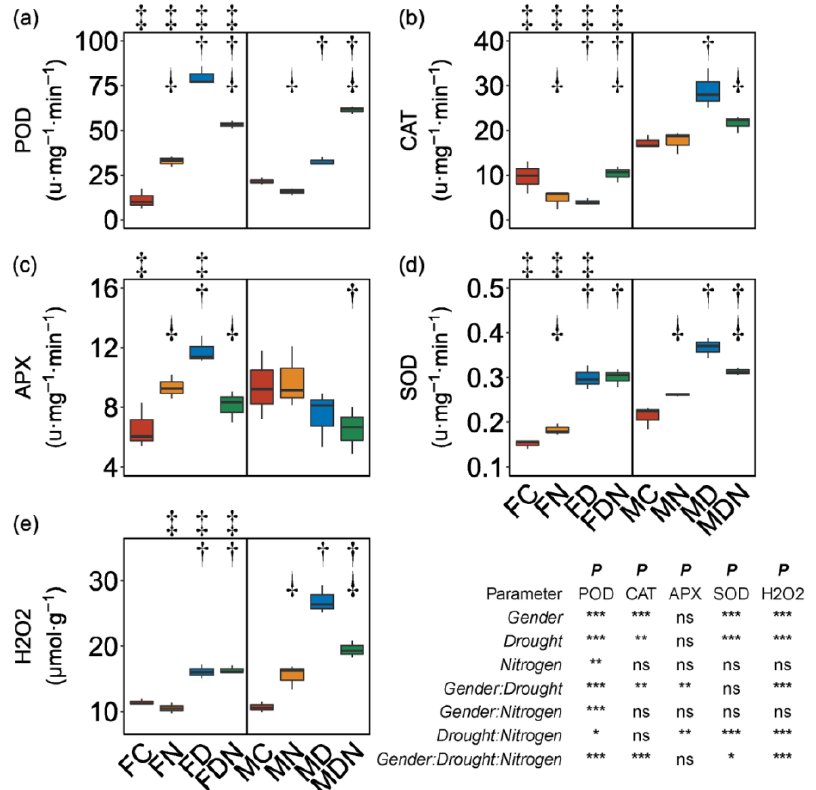
Figure 5. The H 2 O 2 content and antioxidant enzyme activity of leaves ( n = 3). ( a ) POD; ( b ) CAT; Figure 1. The phenotypic parameters of S. myrtillacea cuttings. ( a ) Morphology of cuttings after treatments. The black line denotes 10 cm length; ( b ) the height of cuttings ( n = 6); ( c ) the base ( c ) APX; ( d ) SOD; ( e ) H 2 O 2. F, females; M, males; C, control; N, N deposition; D, drought; DN, drought diameter of cuttings ( n = 6). F, females; M, males; C, control; N, N deposition; D, drought; DN, and N deposition. The double dagger (‡) indicates simple effect of gender, the dagger (†) indicates drought and N deposition. The double dagger (‡) indicates simple e ff ect of gender, the dagger (†) indicates simple effect of drought, and the inverted dagger ( ⸸ ) indicates simple effect of N simple effect of drought, and the inverted dagger ( deposition. Different letters indicate significant differences (Tukey test, p < 0.05). The black dot indicates outlier. Asterisks denote significant differences: ***, p < 0.001; **, p <